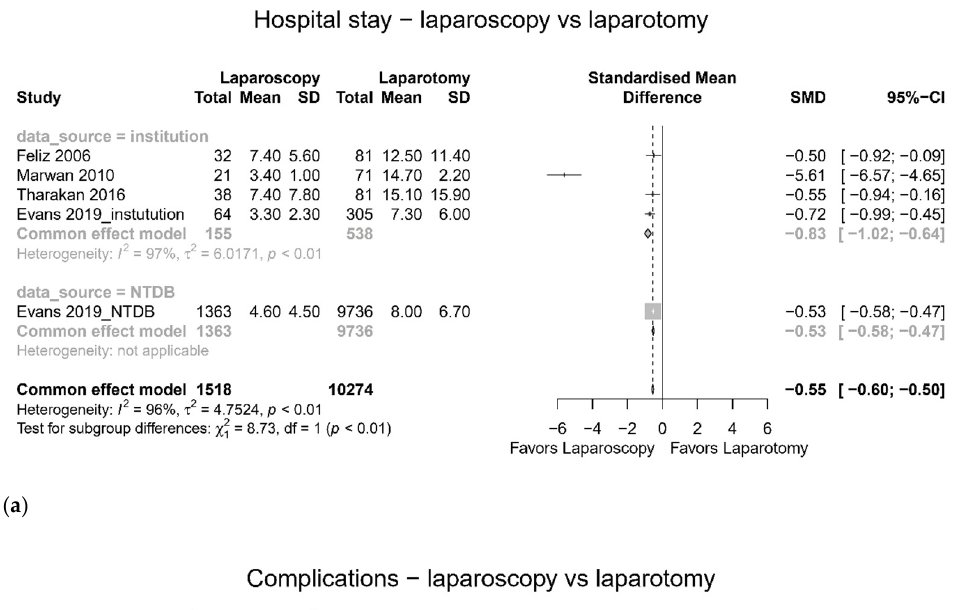
Figure 2. Age, injury severity score (ISS), and operation time (laparoscopy versus laparotomy). ( a ) age, ( b ) ISS, and ( c ) operation time.